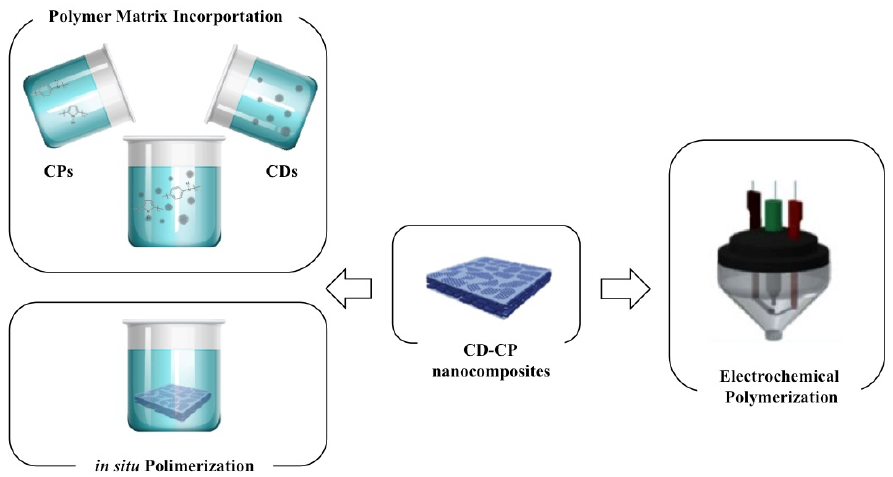
Figure 5. General scheme of the fabrication and processing methods of carbon dot–conductive polymer (CD–CP) nanocomposites.